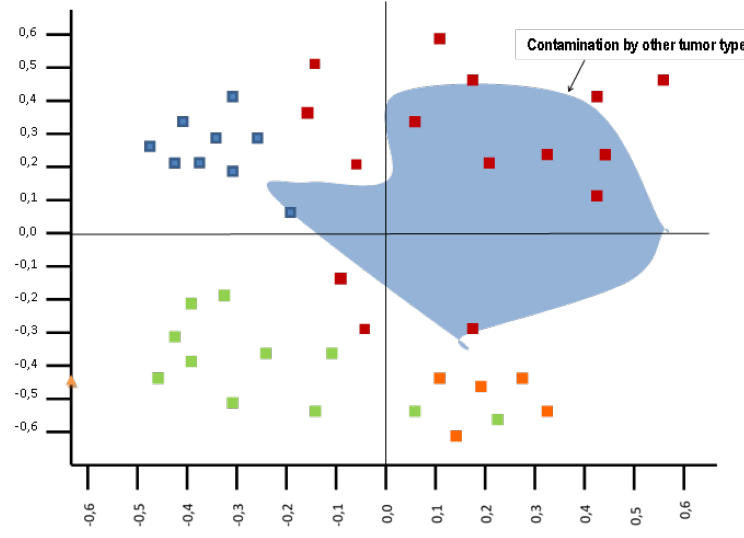
Figure 1. Principle component analysis of gene expression of a series of 10 types of soft tissue tumor (synovial sarcoma, myxoid/ round cell liposarcoma, well-differentiated liposarcoma, dedifferentiated liposarcoma, lipoma, myxofibrosarcoma, leiomyosarcoma, malignant peripheral nerve sheath tumor, fibrosarcoma, MFH). Gene expression overview of the 105 soft tissue tumors with 12,599 probe sets. Each square represents an individual analysed tumor; Nakayama et al .